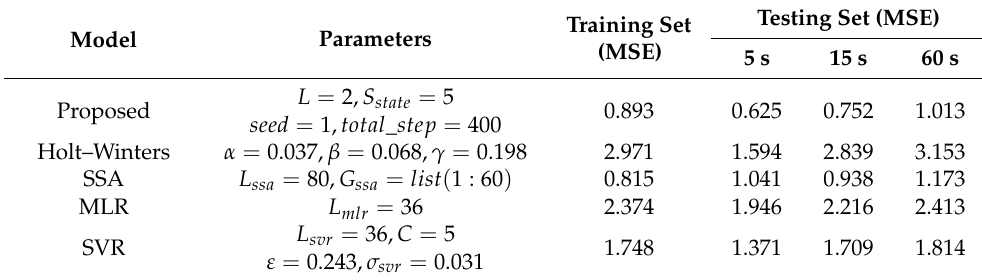
Table 3. The comparison of the proposed Res-LSTM and other models.